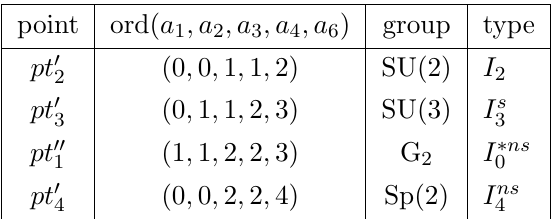
Table 9. Some examples of the correspondence between additional lattice points in r associated with a ray v ( B ) in the base and the associated tuning of the Tate coe(cid:14)cients ( a 1 ; a 2 ; a 3 ; a 4 ; a 6 ) over the associated divisor.